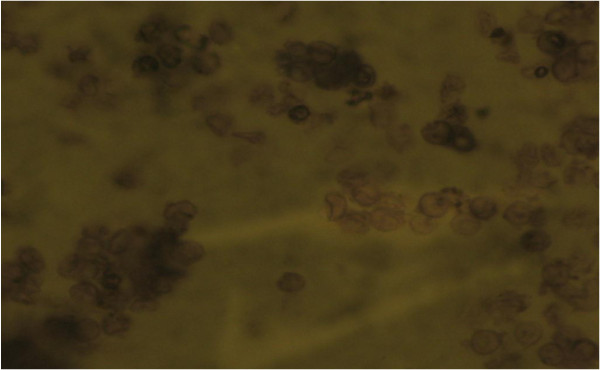
Picture of sickle cell patient blood treated with Carica papaya seed oil (Magnification: x1000).